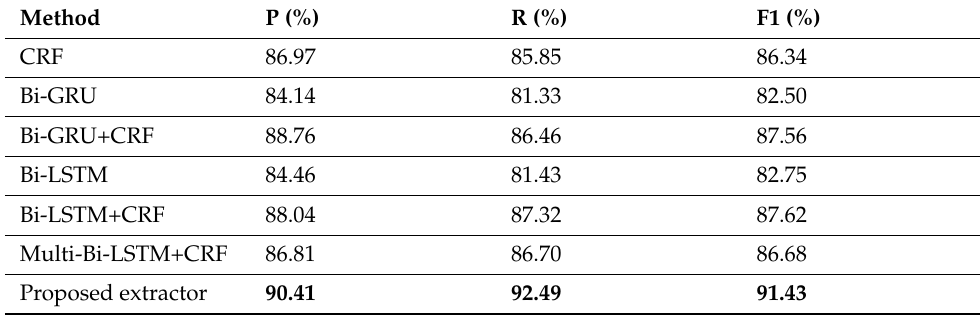
Table 6. Comparison results of the deep learning-driven extractor and